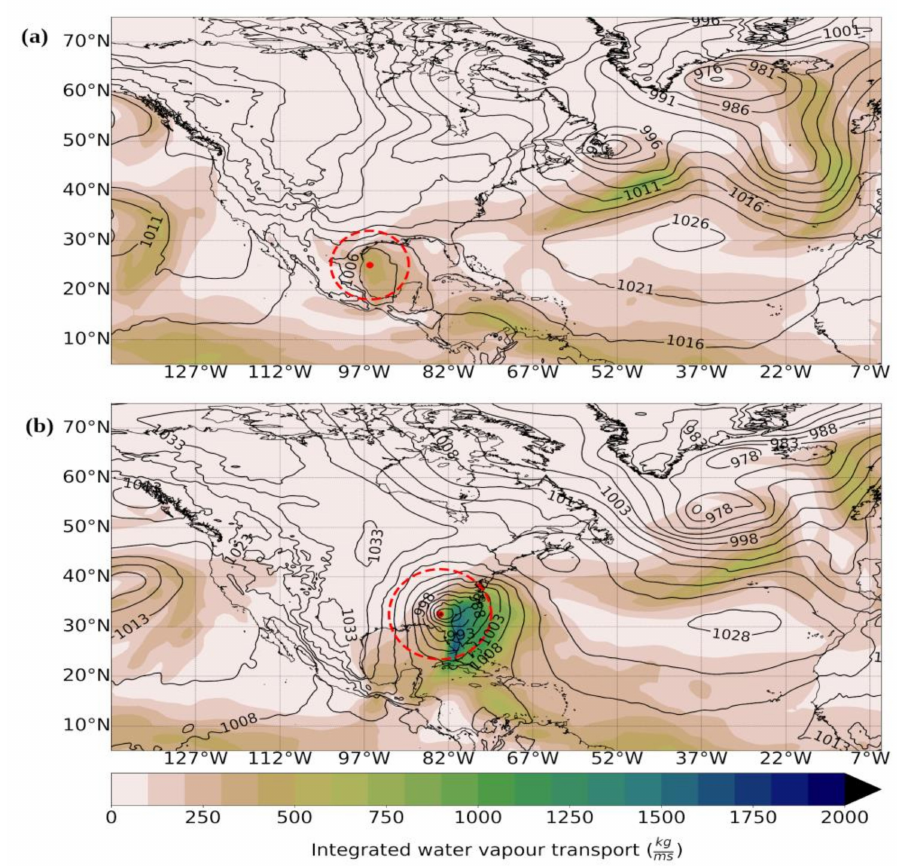
Figure 2. Integrated water vapour transport (shaded) and mean sea level pressure (contours) for ( a ) 12 March 1993 at 1200 UTC and ( b ) 13 March 1993 at 1200 UTC. The red-dashed circles denote the SC93 size, while the position of the storm is marked with a filled